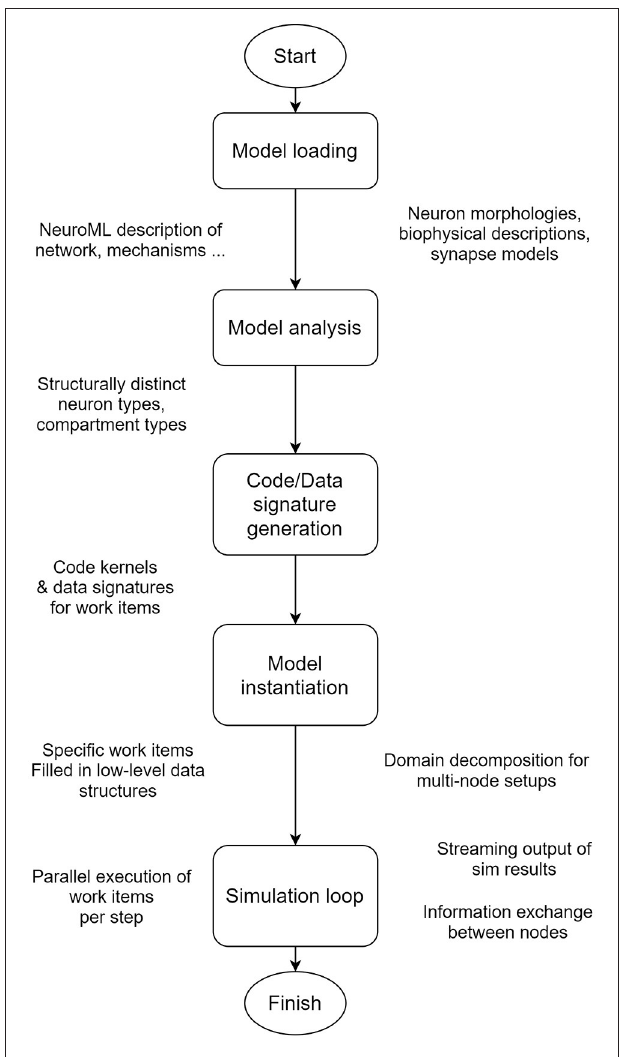
FIGURE 2 | EDEN’s processing pipeline. The whole model is analyzed in order to extract the computationally similar parts of neurons, and to generate optimized code and data representations for them, on the